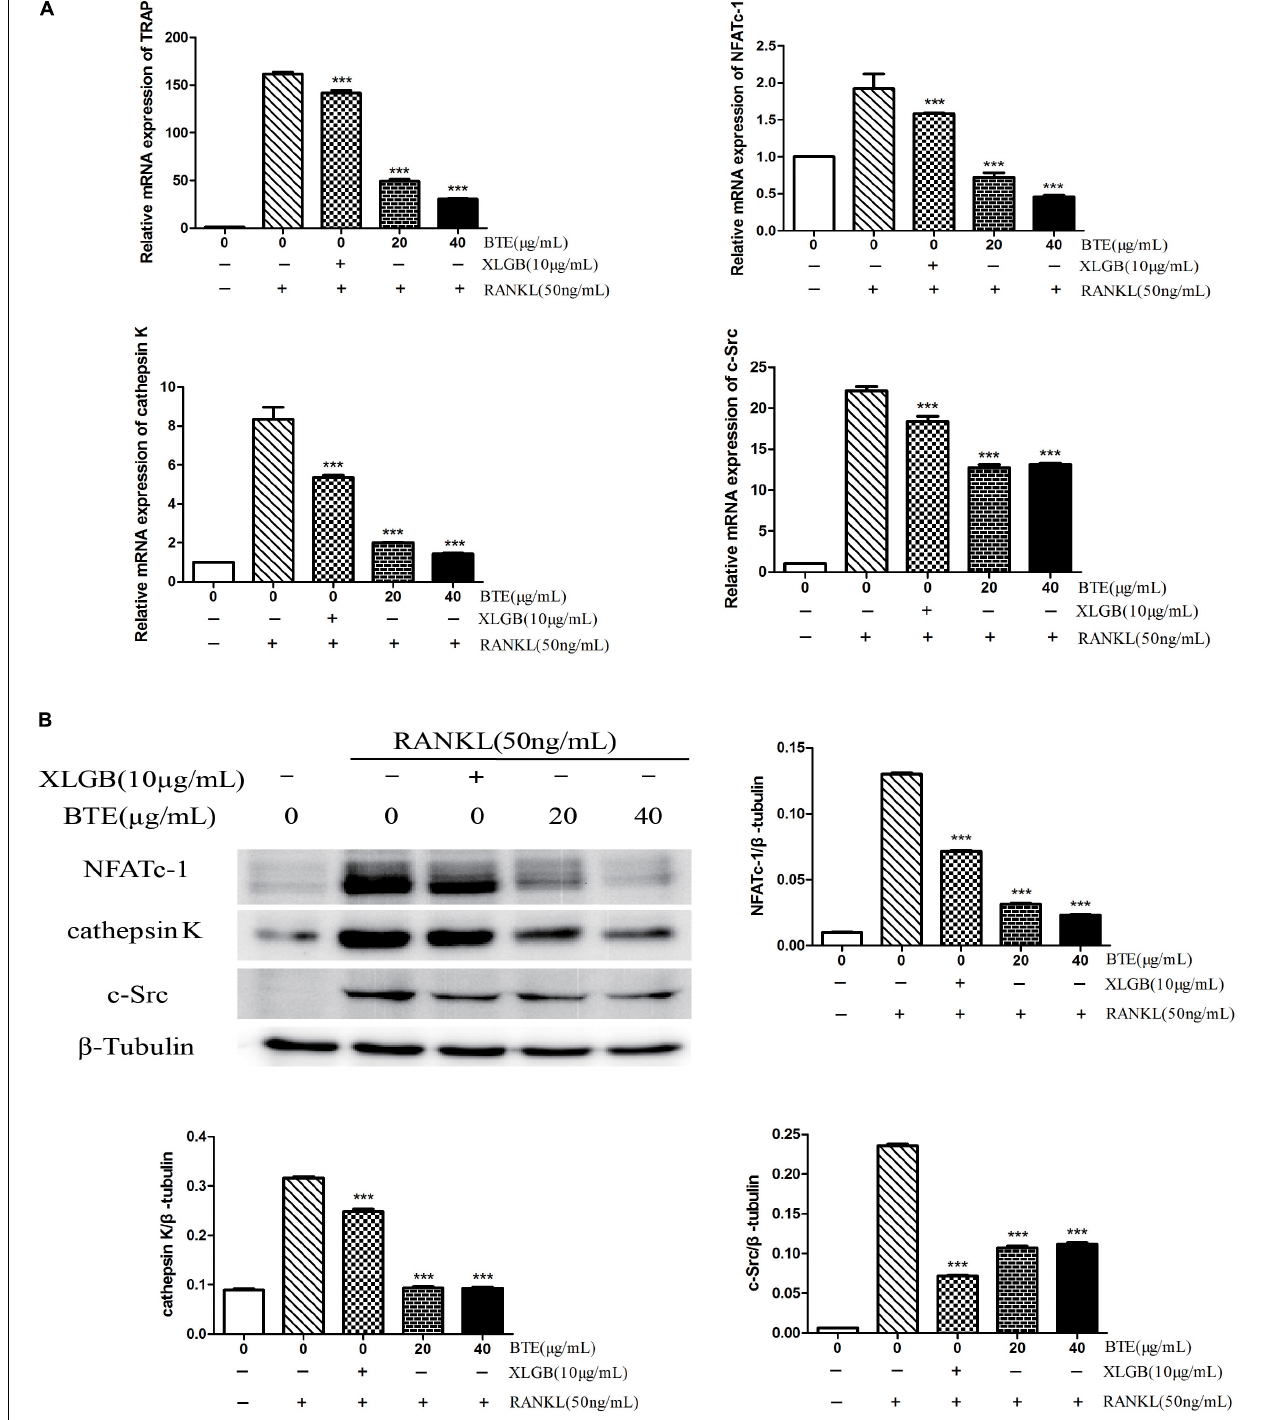
FIGURE 5 | The Effects of black tea extract (BTE) on the expression of genes and proteins related osteoclastogenesis. The levels of specific genes and proteins were determined using qRT-PCR and western blotting for osteoclasts treated with BTE. (A) The mRNA expression levels of TRAP, NFATc-1, cathepsin K, and c-Src. (B) The protein expression levels of NFATc-1, cathepsin K, and c-Src and the results were quantified using AlphaView software. All data are presented as the mean ± SEM ( n = 3). “One way ANOVA” was used for the comparison of BTE treatment vs only RANKL treatment. ∗∗∗ p < 0.001 vs only RANKL treatment.